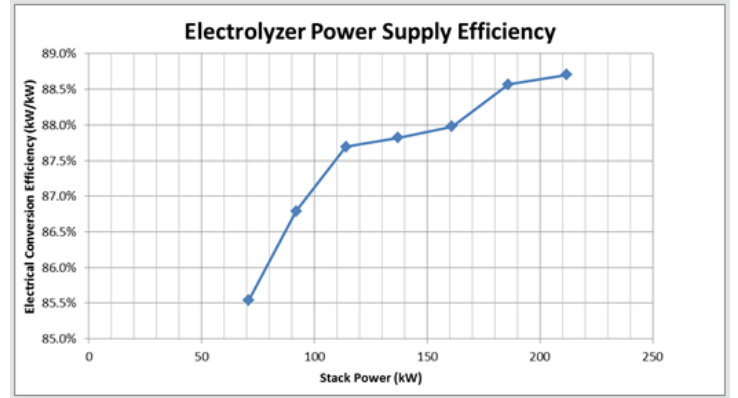
Figure 6. The efficiency of the power supplies for the electrolyzer, given as the fraction of DC power per unit AC power for different power consumption